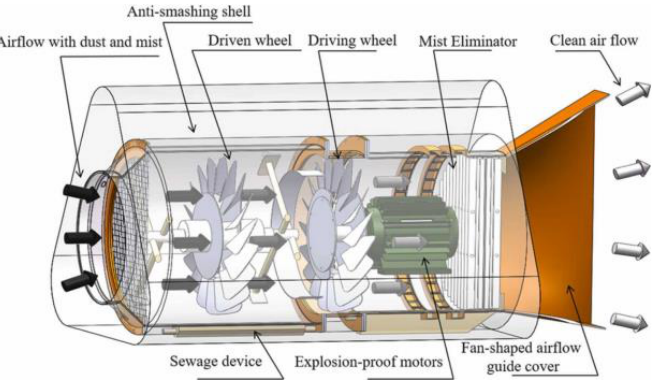
Figure 1. Working principle of the dust removal fan proposed by Xiu et al. [5].